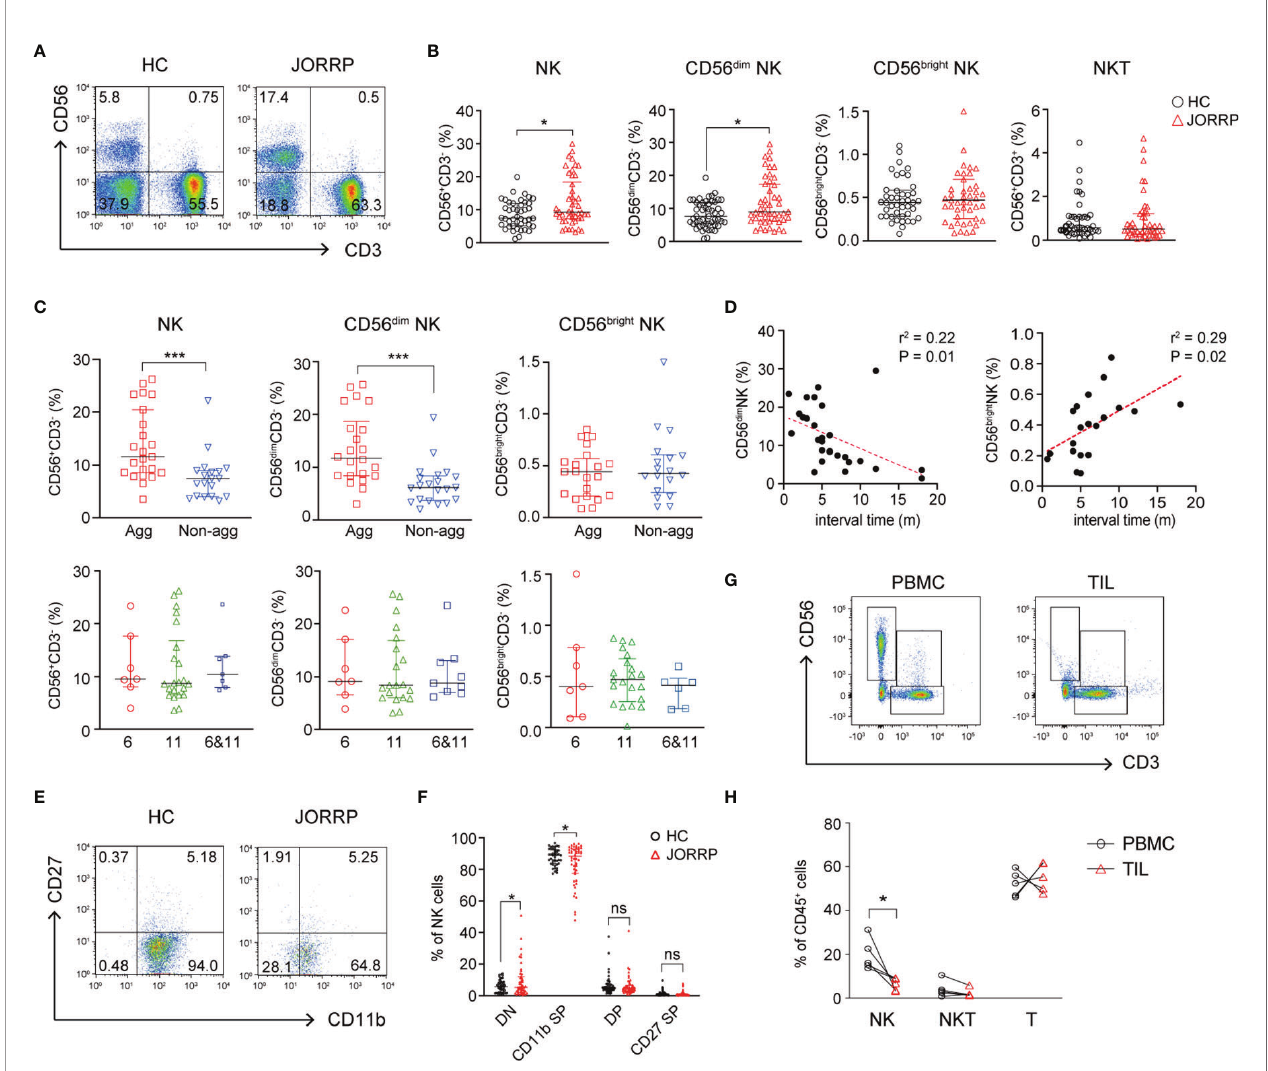
FIGURE 1 | CD56 dim NK cells are cumulated in the peripheral blood and correlated with disease activity in Juvenile-Onset Recurrent Respiratory Papillomatosis (JORRP) patients. (A, B) Representative graphs and percentage analyses of NK cells in the peripheral blood of JORRP patients (n = 48) and HCs (n = 51). (C) Percentage analysis of NK cells in the PBMCs of different subgroups of JORRP patients. Agg, aggressive (n = 23); Non-agg, non-aggressive (n = 19); 6, HPV6 (n = 7); 11, HPV11 (n = 22); 6&11, HPV6&HPV11 (n = 7). Note: Patients with recurrence were not included in the aggressive/non-aggressive group. The genotyping of some JORRP patients was unde fi ned due to limited tumor volume. (D) Correlation of CD56 dim NK or CD56 bright NK cell percentages with interval time of surgical reoccurrence. Spearman ’ s correlation coef fi cients are shown. m, months. (E, F) Representative graphs and fl ow cytometry analyses of the expression of CD27 and CD11b on gated CD56 + CD3 - NK cells in the peripheral blood of JORRP patients (n = 48) and HCs (n = 48). DN, CD27 and CD11b double-negative NK cells; CD11b SP, CD11b single positive NK cells; DP, CD27 and CD11b double-positive NK cells; CD27 SP, CD27 single-positive NK cells. (G, H) Representative graphs and percentage analyses of NK cells in the peripheral blood and tumor of JORRP patients (n = 5). PBMC, peripheral blood mononuclear cell; TIL, tumor-in fi ltrating lymphocyte. Data are presented as median with interquartile range. Each dot represents a single patient. ns, not signi fi cant; *P < 0.05; ***P <